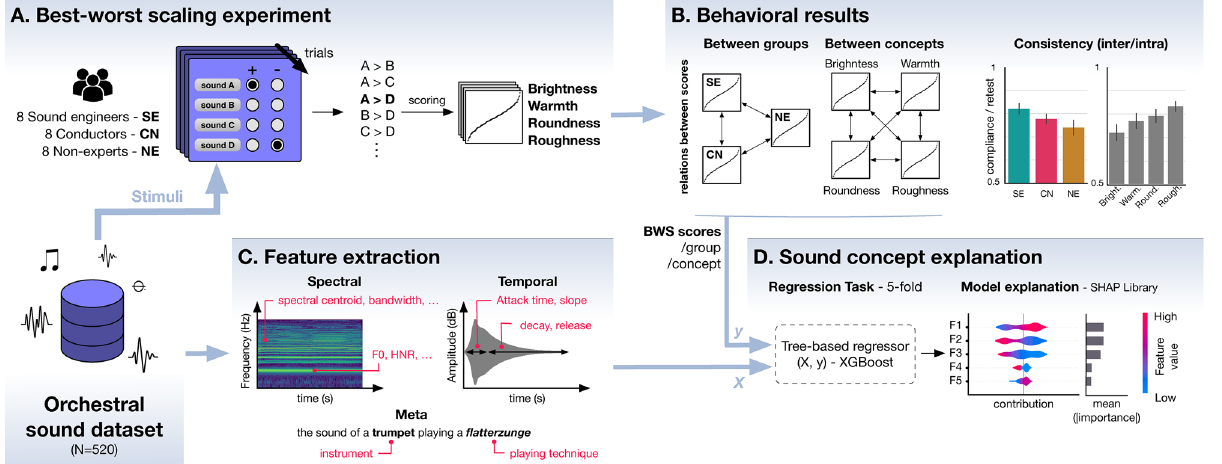
Figure 1. Schematic view of the methodology used to investigate the mental representations associated with specific sound concepts for different populations. ( A ) We collected ratings on an orchestral sound dataset using four sound concepts from three participant groups with the Best–Worst Scaling methods. ( B ) Using these ratings, we computed consistency metrics and measured similarities and differences between groups and between concepts. ( C ) We extracted acoustic features (e.g., spectral centroid, attack slope) and meta features (i.e., instrument, playing technique) from the sound dataset. ( D ) We trained a tree-based model and assessed the most important features for the prediction of the